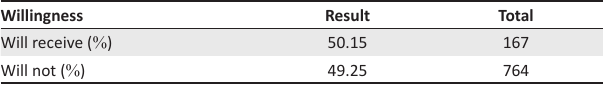
TABLE 3: Will Graduate Students Receive Instruction Using NC?